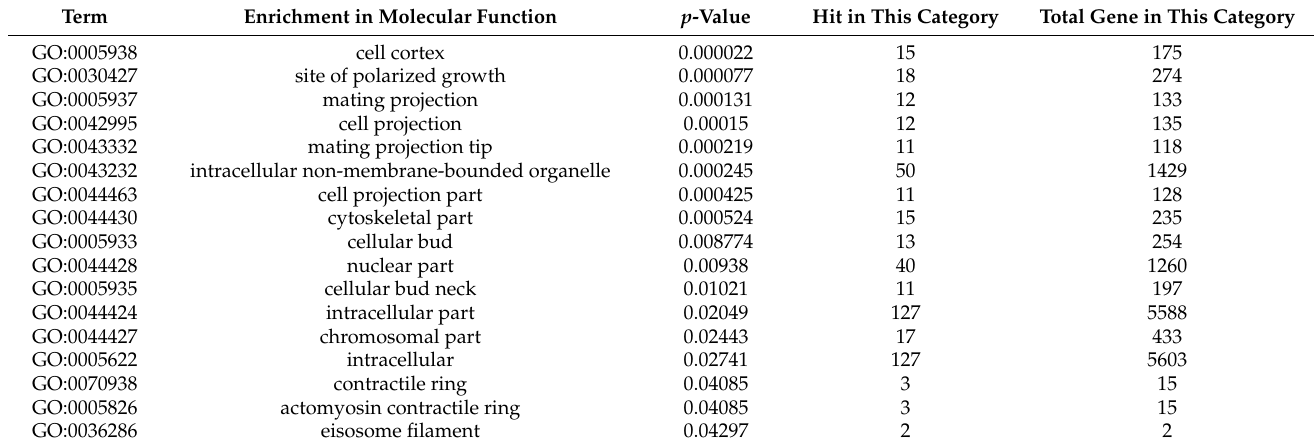
Table 2. Enrichment categories in GO cellular component for protein targets of Sub5.